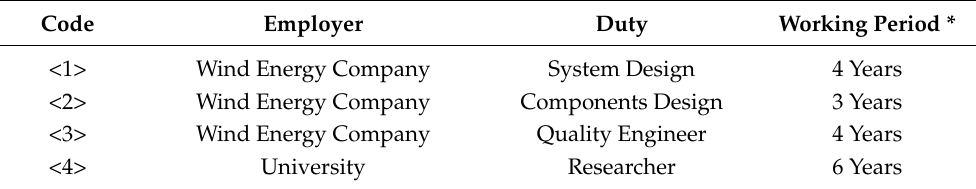
Table 2. Specialists involved in the failure analysis of floating offshore wind turbines.